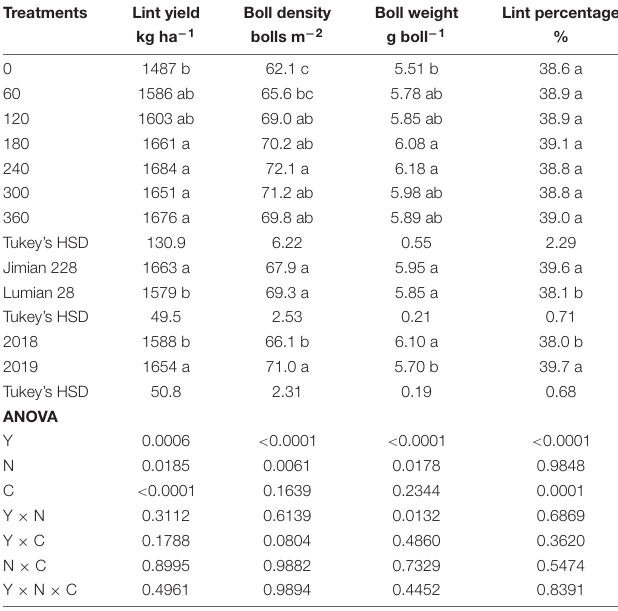
TABLE 1 | Lint yield, boll density, boll weight, and lint percentage in response to year (Y), N application rate (N), and cultivar (C).